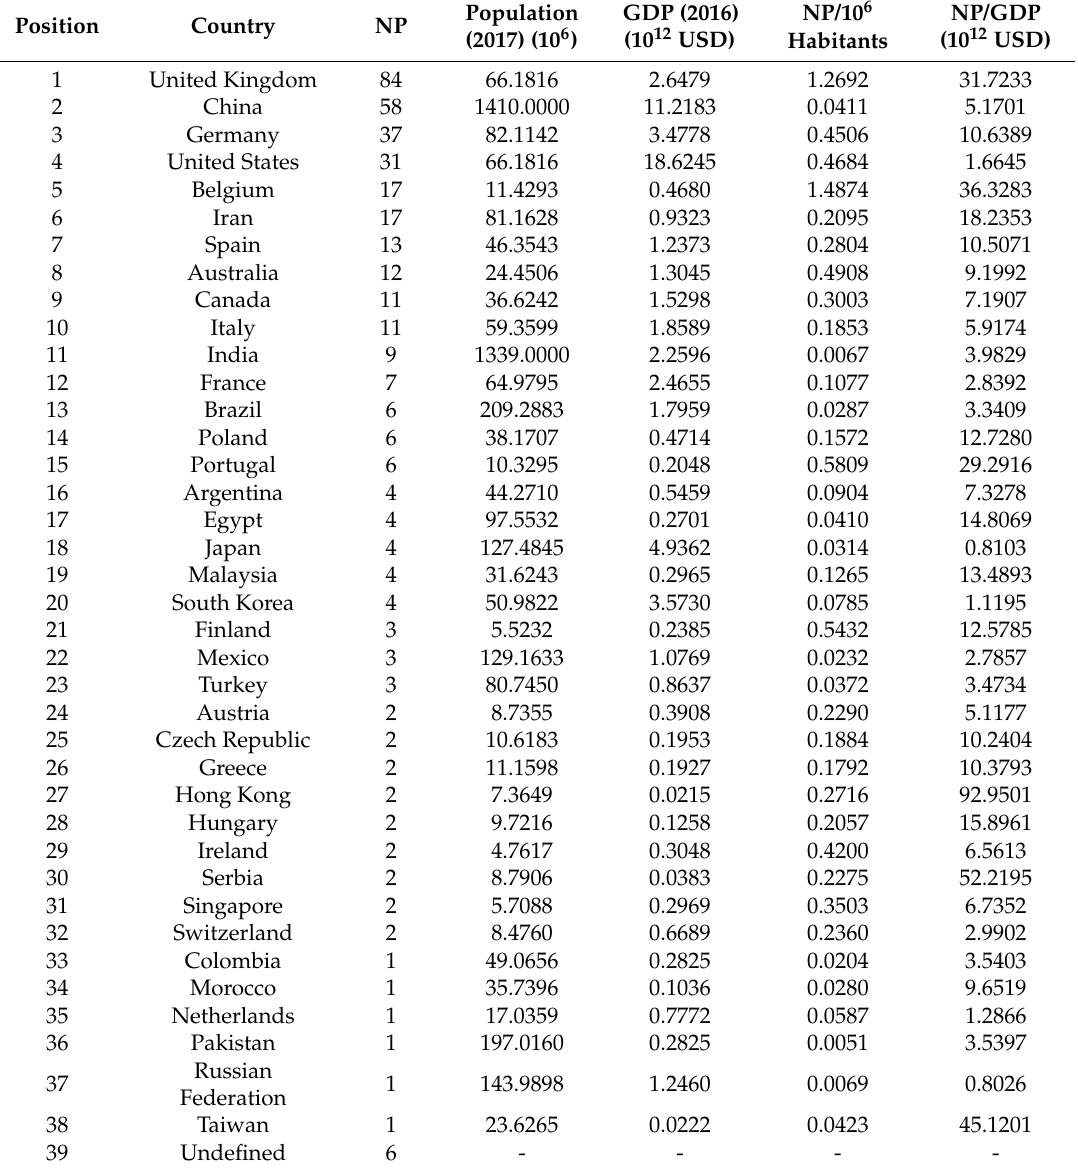
Table 7. Publications per country, population in 2017, gross domestic product (GDP) (reference to 2016, in 10 12 USD), number of publications (NP) per million of habitants, and the ratio of number of publications per respective